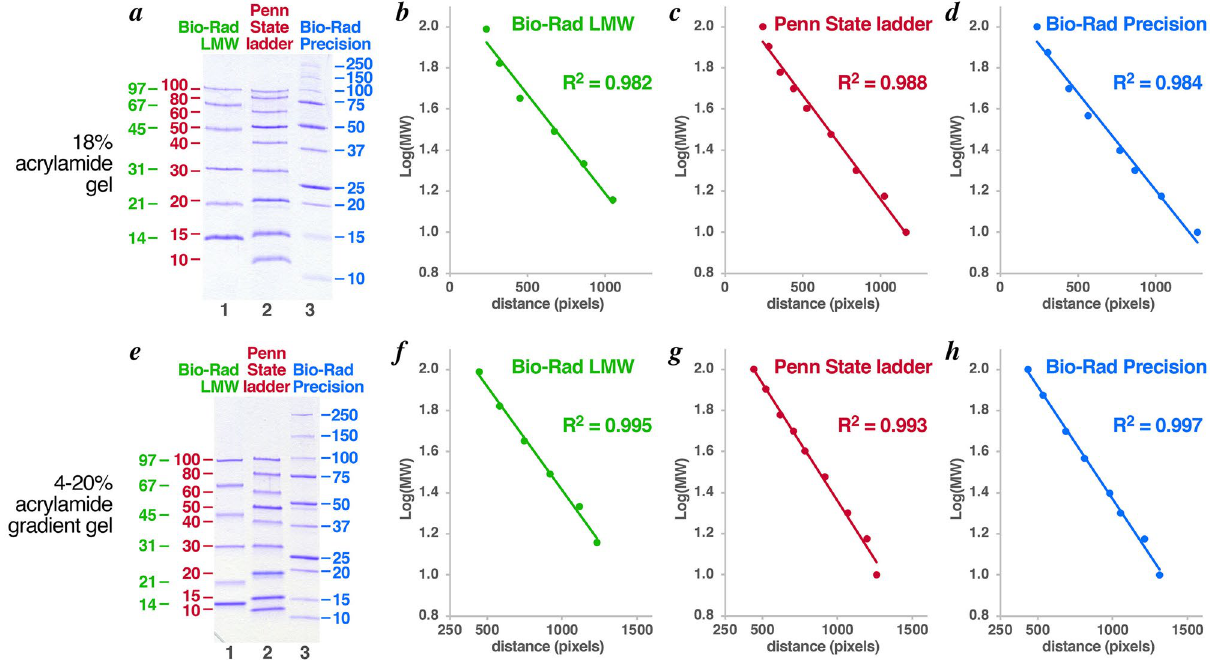
Figure 4. Comparison of Penn State protein ladder with commercial protein ladders. ( a ) SDS-PAGE of Bio-Rad low molecular weight (LMW) markers (lane 1, green), Penn State 10-100 kD ladder (lane 2, red) and Bio-Rad Precision Plus protein ladder (lane 3, blue) on 18% acrylamide gel. Sizes of bands in kD are shown to the sides. Semi-log plots of the LMW markers, Penn State ladder and Precision Plus ladder with R 2 goodness of fit for the samples shown in panel ( a ) are shown in panels ( b ), ( c ) and ( d ) respectively. The equivalent panels for samples electrophoresed through a 4-20% acrylamide gradient gel (Bio-Rad, 456-1093) are shown in panels ( e ) through ( h